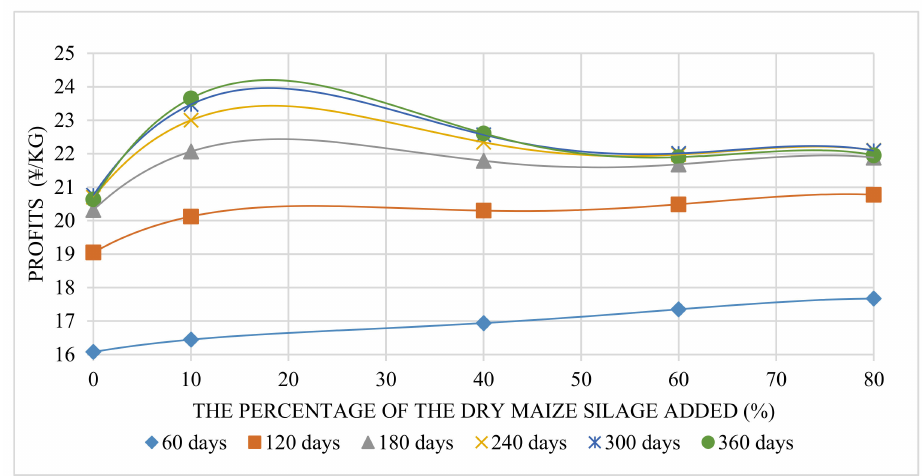
Figure 7. Profits were gained with different percentages of sun-dried maize silage added.